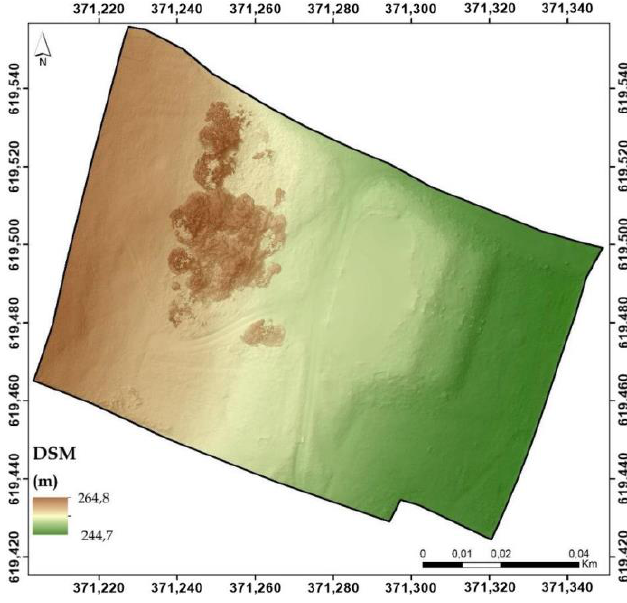
Figure 14. Digital surface area.